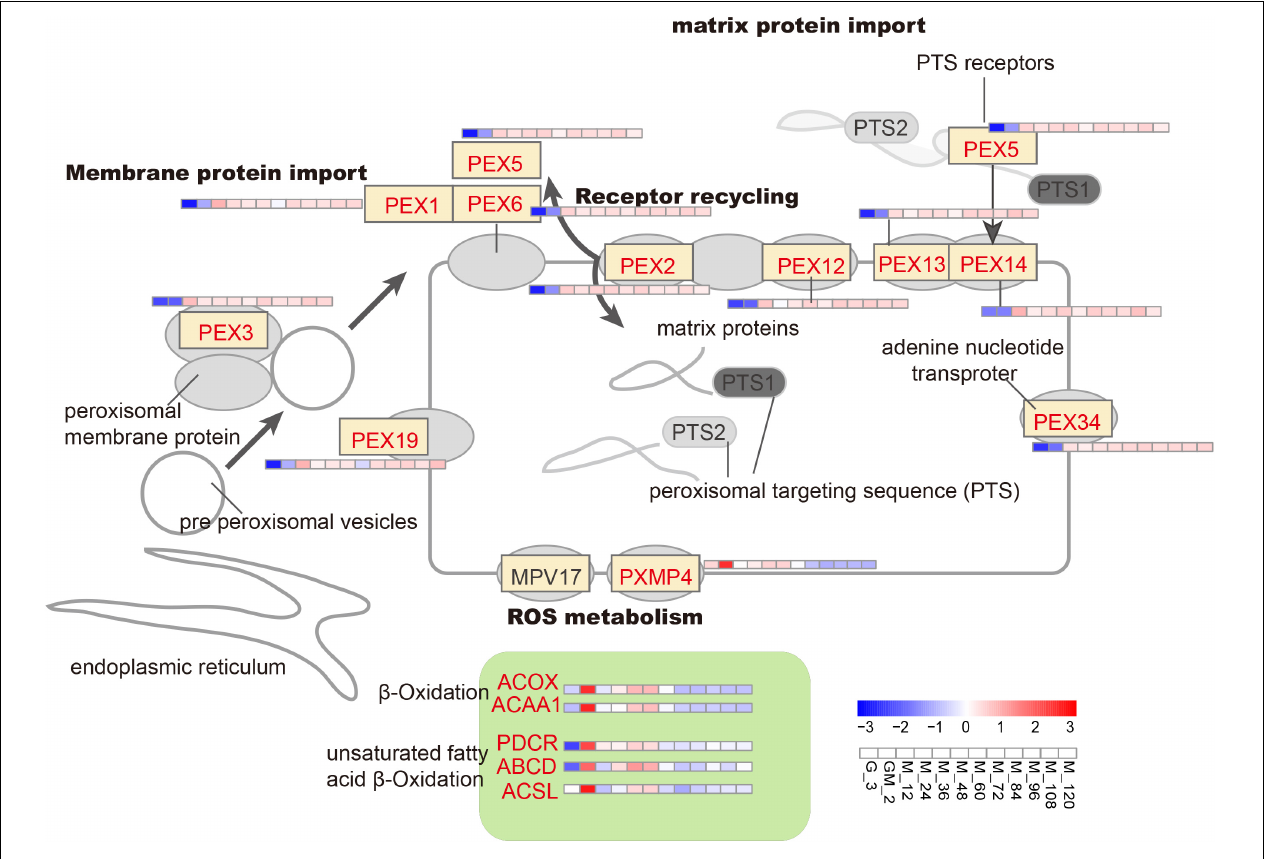
FIGURE 4 | Changes in proteins involved in the oxidative stress metabolic